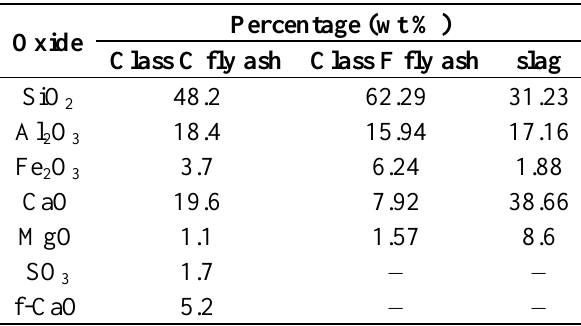
Table 1. Chemical composition of fly ash and